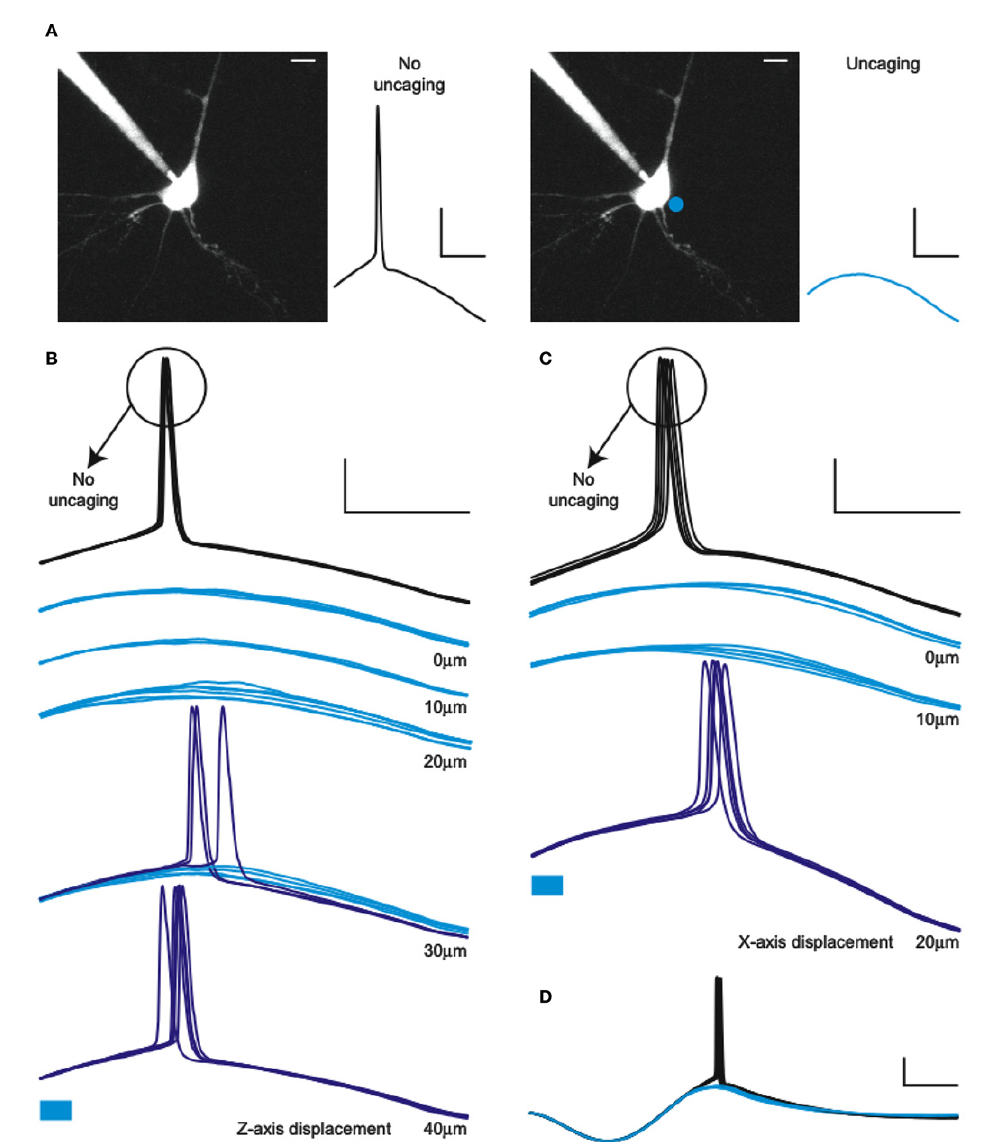
Figure 5 | Optical silencing of neurons with RuBi-GABA. (A) Schematic of the experiment showing the recorded neuron and two alternating trials, one with no uncaging (left, black) and one with uncaging pulse delivered to a peri-somatic spot (right, cyan),which abolishes the action potential (AP). (B) Example of an experiment in which 5 ms laser pulses were used to prevent AP fi ring of a layer 2/3 neuron in mouse visual cortex in response to a sinusoidal current injection. Cyan traces represent successful silencing, while the blue traces show the failures of silencing (therefore AP generation), illustrating a 30- μ m axial resolution for this effect. (C) Same as (B) , but illustrating the lateral resolution. Cyan bars below traces indicate the uncaging laser pulse. (D) Example of a full cycle sinusoidal stimulation with and without AP silencing due to RuBi-GABA uncaging. Scale bars: 20 mV, 20 ms (A–C) , 50 ms (D) , 10 μ